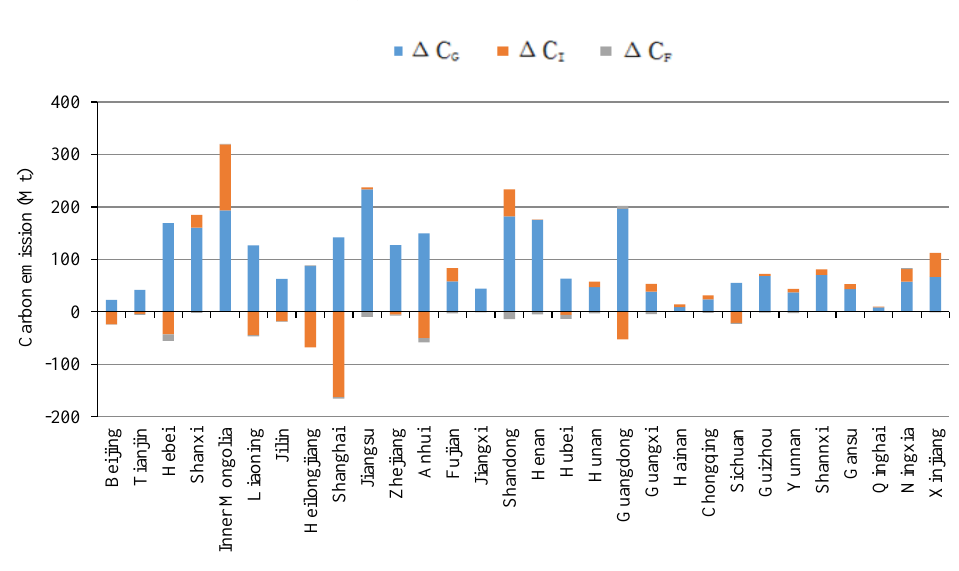
Figure 6. Decomposition of changes in CO 2 emissions across the 30 provincial power grids in China, 2000–2013 (absolute terms).